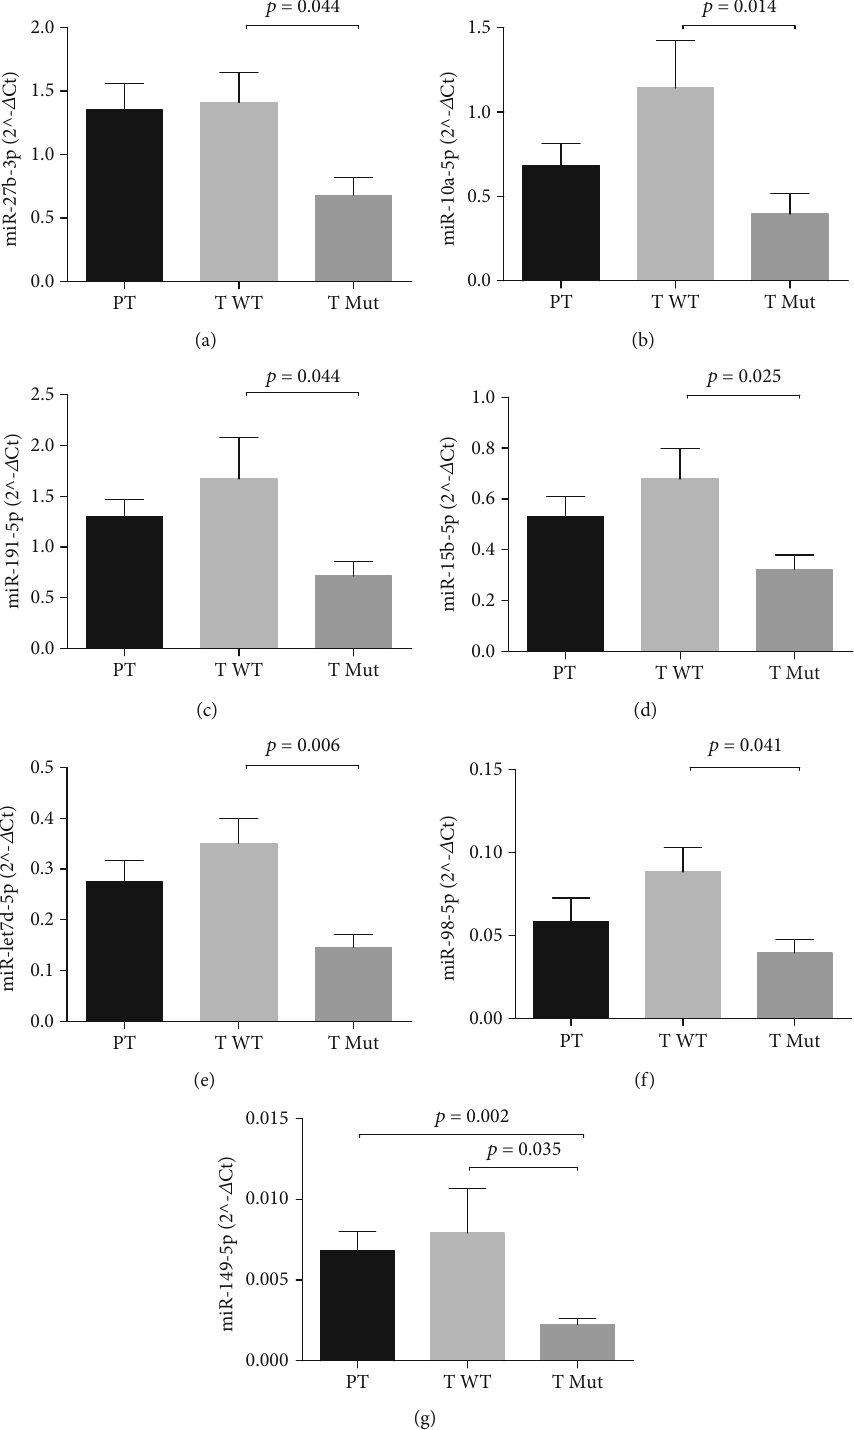
Figure 2: (a – g) The graphs show the signi fi cant miRNAs di ff erentially expressed among the groups (PT: peritumoral; T WT: tumoral KRAS wild type; T Mut: tumoral KRAS mutated). Bar graphs represent the mean of the 2 − Δ Ct values, and error bars represent the standard error. (a) miR-27b-3p. (b) miR- 10a-5p. (c) miR-191-5p. (d) miR-15b-5p. (e) miR-let7d-5p. (f) miR-98-5p. (g) miR- 149-5p. p value has been calculated using Kruskal – Wallis test followed by pairwise